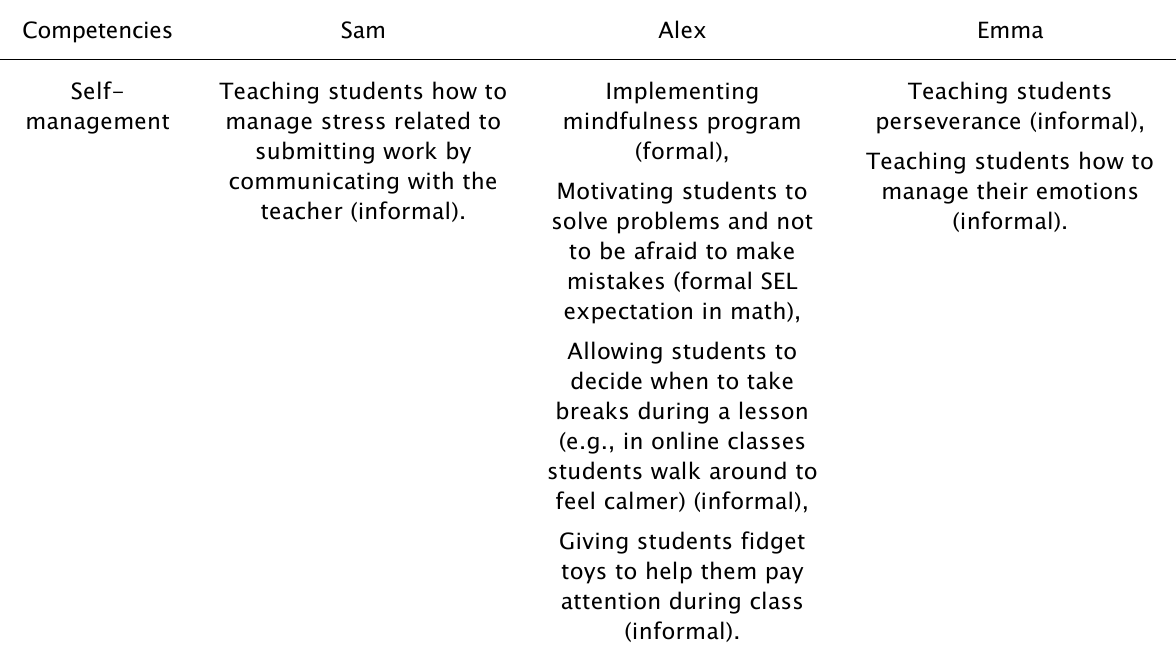
Table 3 (Cont’d) Strategies to Teach SEL Competencies During COVID-19